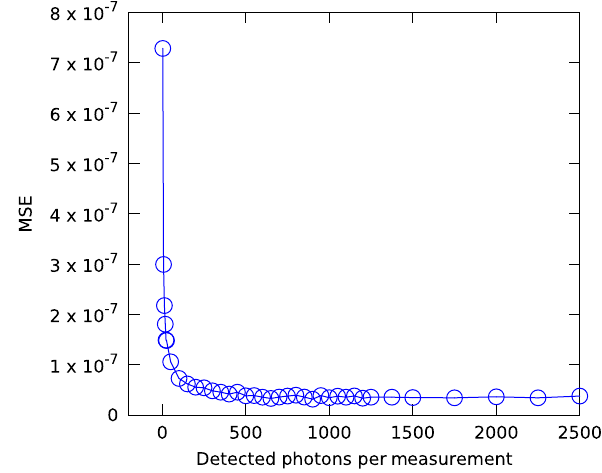
FIG. 3. Simulated MSE versus photon flux for n ¼ 256 and m ¼ 2500 . The phase-change behavior versus photon number can be clearly seen. The experiment uses 5000 total (1250 detected) photons per measurement to comfortably exceed the phase change. The MSE approaches a value of 5 (cid:1) 10 (cid:2) 8 , which corresponds to a SNR of about